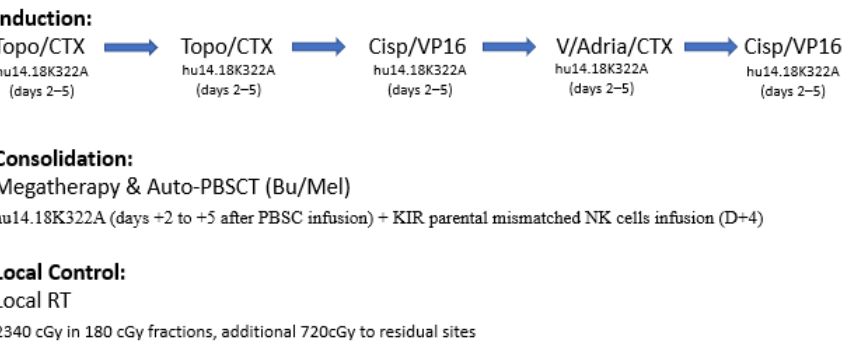
Figure 6. Treatment schema of St. Jude immunotherapy (hu14.18K322A) with GM-CSF and IL-2 during induction and maintenance phases. Some patients also received haploidentical NK cell infusion after auto-PBSCT.